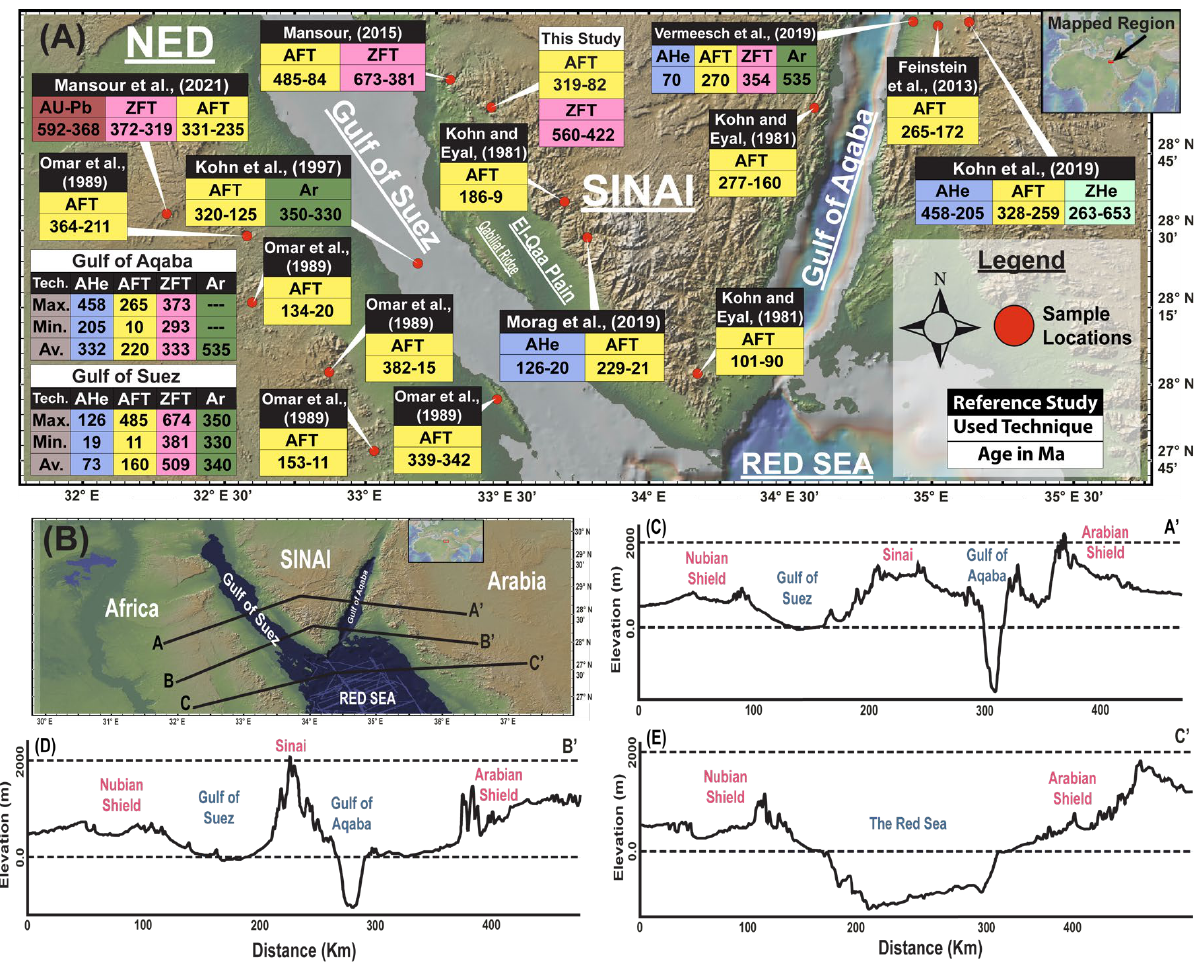
Figure 1. ( A ) Location map based on digital elevation model (www.geomapapp.org, accessed on 25 October 2022) representing the previous thermochronologic studies in the northern ANS and Sinai [6,14,15,17,20,22–24]. Where NED = Northeastern Desert; Ar = Ar-Ar dating; ZFT = zircon fission-track, ZHe; zircon (U-Th)/He, AFT = apatite fission-track, and AHe; apatite (U-Th)/He. ( B ) Digital elevation model (www.geomapapp.org) for the ANS representing the location of topographic cross sections ( C ) across the ANS in NED, the Gulf of Suez, the northern exposure of the ANS in Sinai, the Gulf of Aqaba, and the ANS in northern Arabia, ( D ) across the ANS in NED, the Gulf of Suez, the southern exposure of the ANS in Sinai, the Gulf of Aqaba, and the ANS in northern Arabia, ( E ) across the ANS in CED, the Red Sea, and the ANS in central